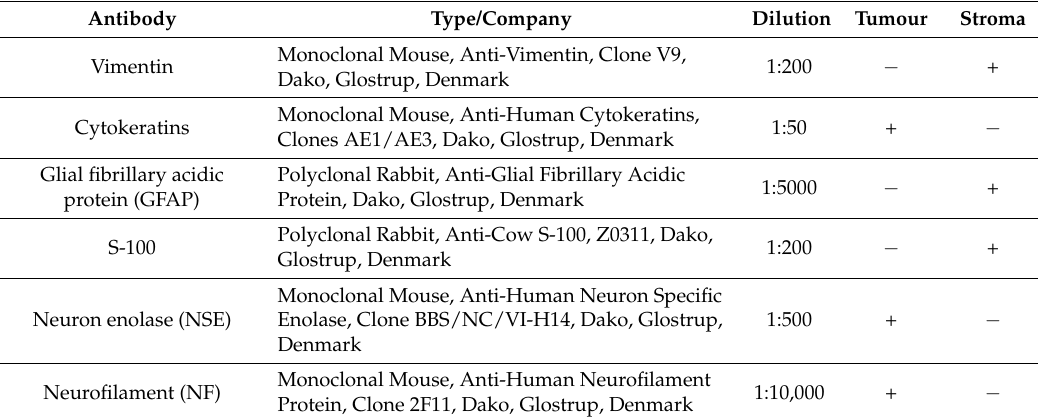
Table 1. Antibodies and their dilution used to perform immunohistochemistry on the brain mass. Antibody Type/Company Dilution Tumour